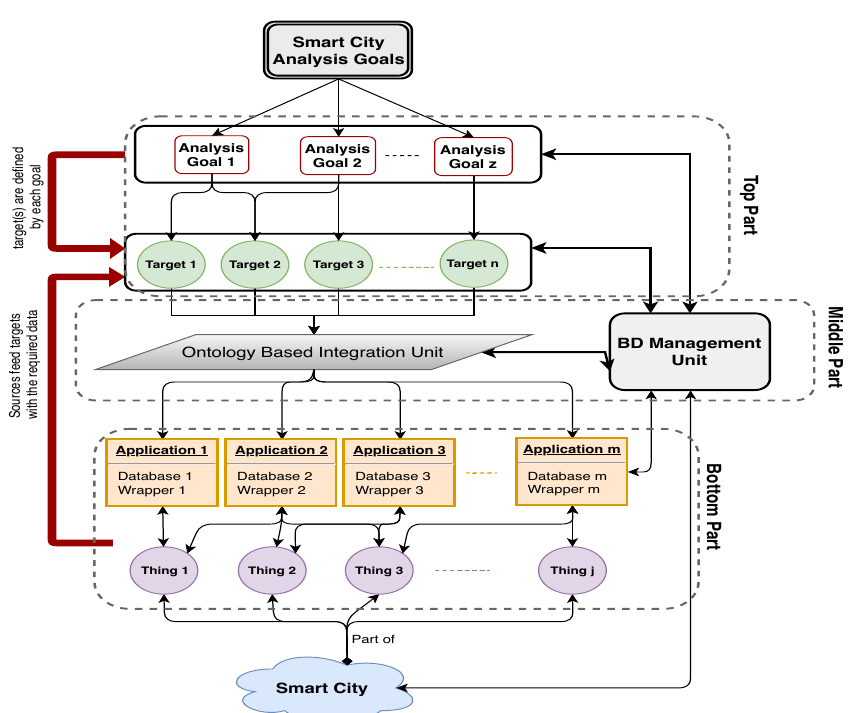
Figure 8. Goal-Oriented Database Integration Model for Big Data of Smart